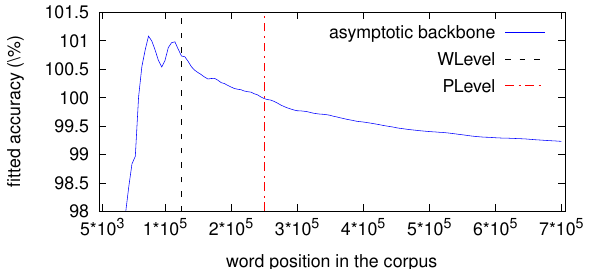
Figure 3. Working and prediction levels for SVMT ool on X iada, with details in